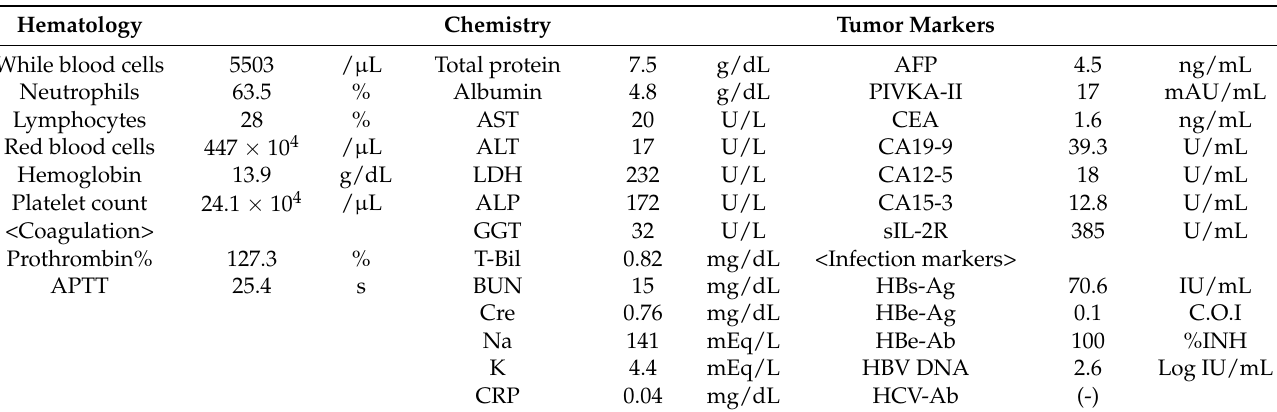
Table 1. Laboratory data on